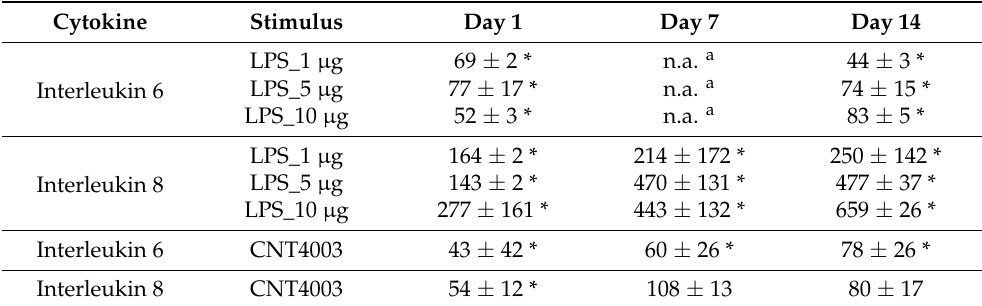
Table 4. Time-dependent changes (%) of cytokine secretion by MucilAir™ tissues upon stimulation with 1, 5 and 10 µ g lipopolysaccharide (LPS) or CNT4003. Secretion of unstimulated tissues is set as 100%. Significant differences ( p < 0.05) between treated and untreated samples are indicated by an asterisk. Abbreviation: n.a., not available. Cytokine Stimulus Day 1